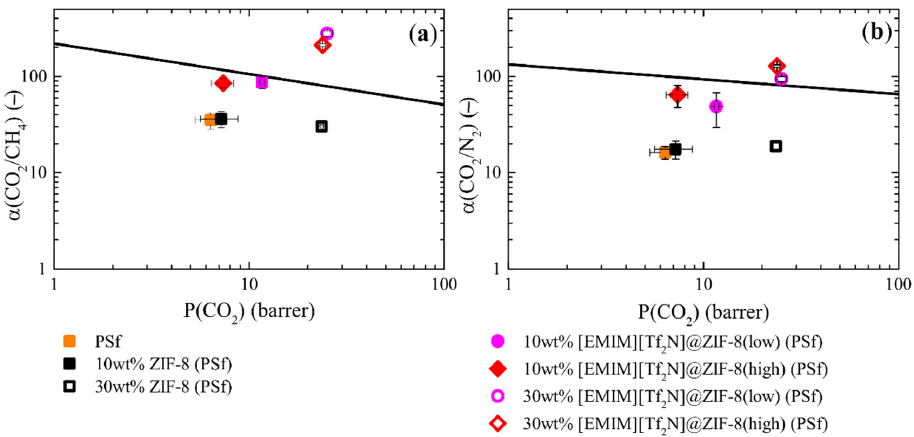
Figure 8. CO 2 pure gas permeation results at 303.15 K for PSf and several MMMs with Figure at 303.15 K for ( a ) CO 2 /CH 4 and ( b ) CO 2 /N 2 ideal selectivities.